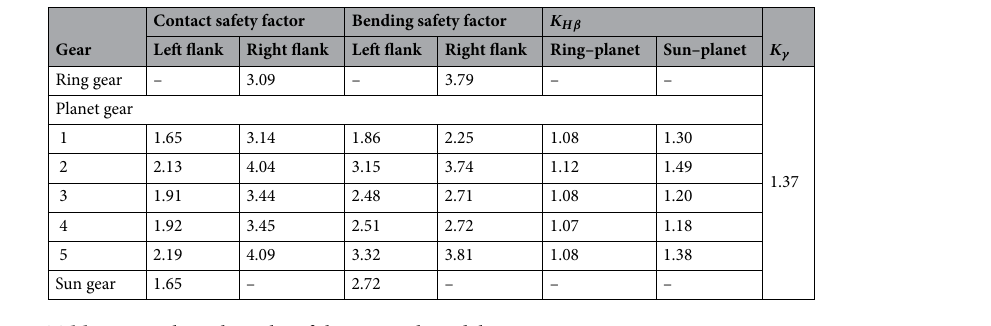
Table 2. Analytical results of the original